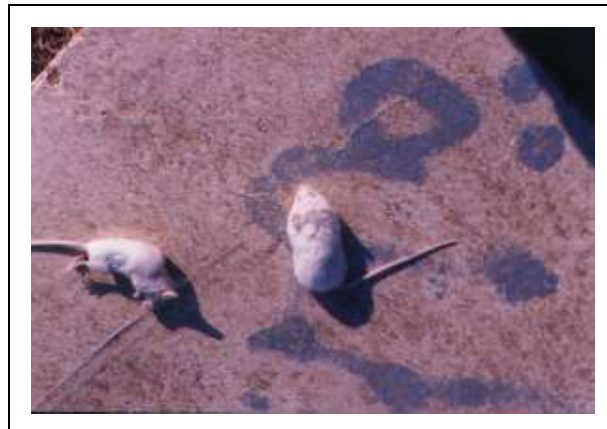
Fig 1 Mouse (from group B)with hypoglycaemic Attack suffering from coma with ataxia of hind limb, dragging its hind limbs to the back